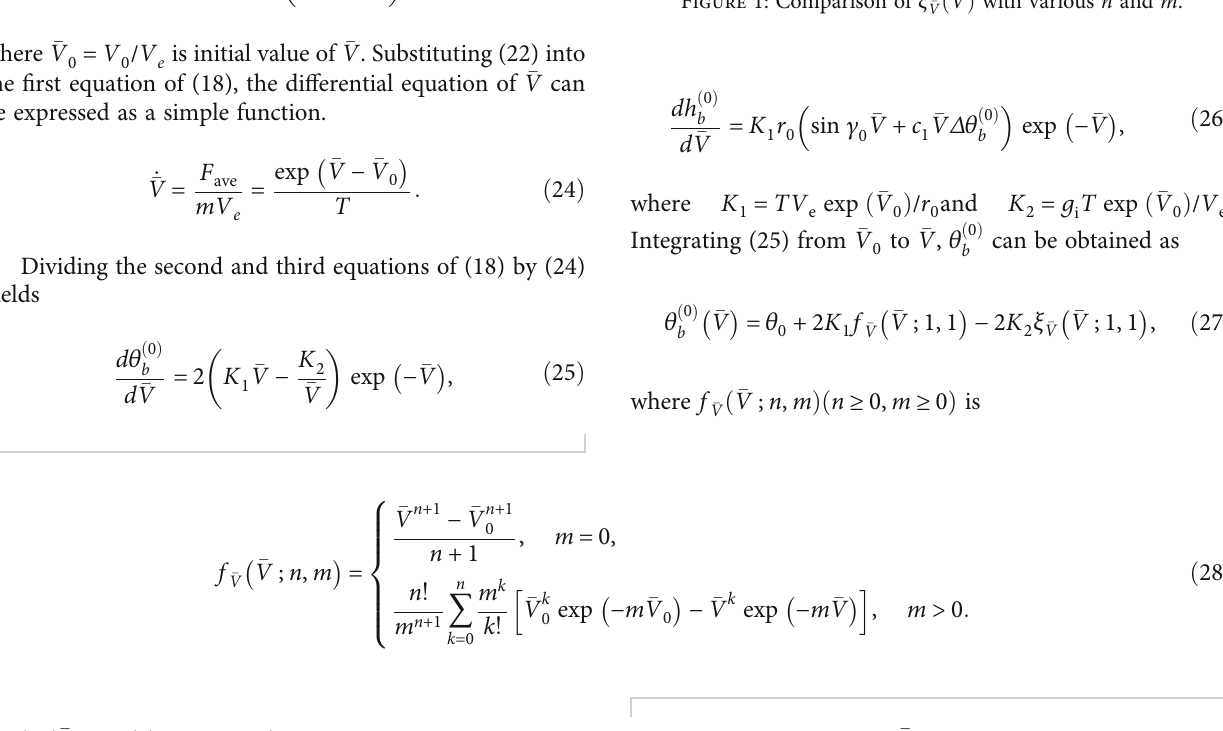
Figure 1: Comparison of ξ (cid:2)